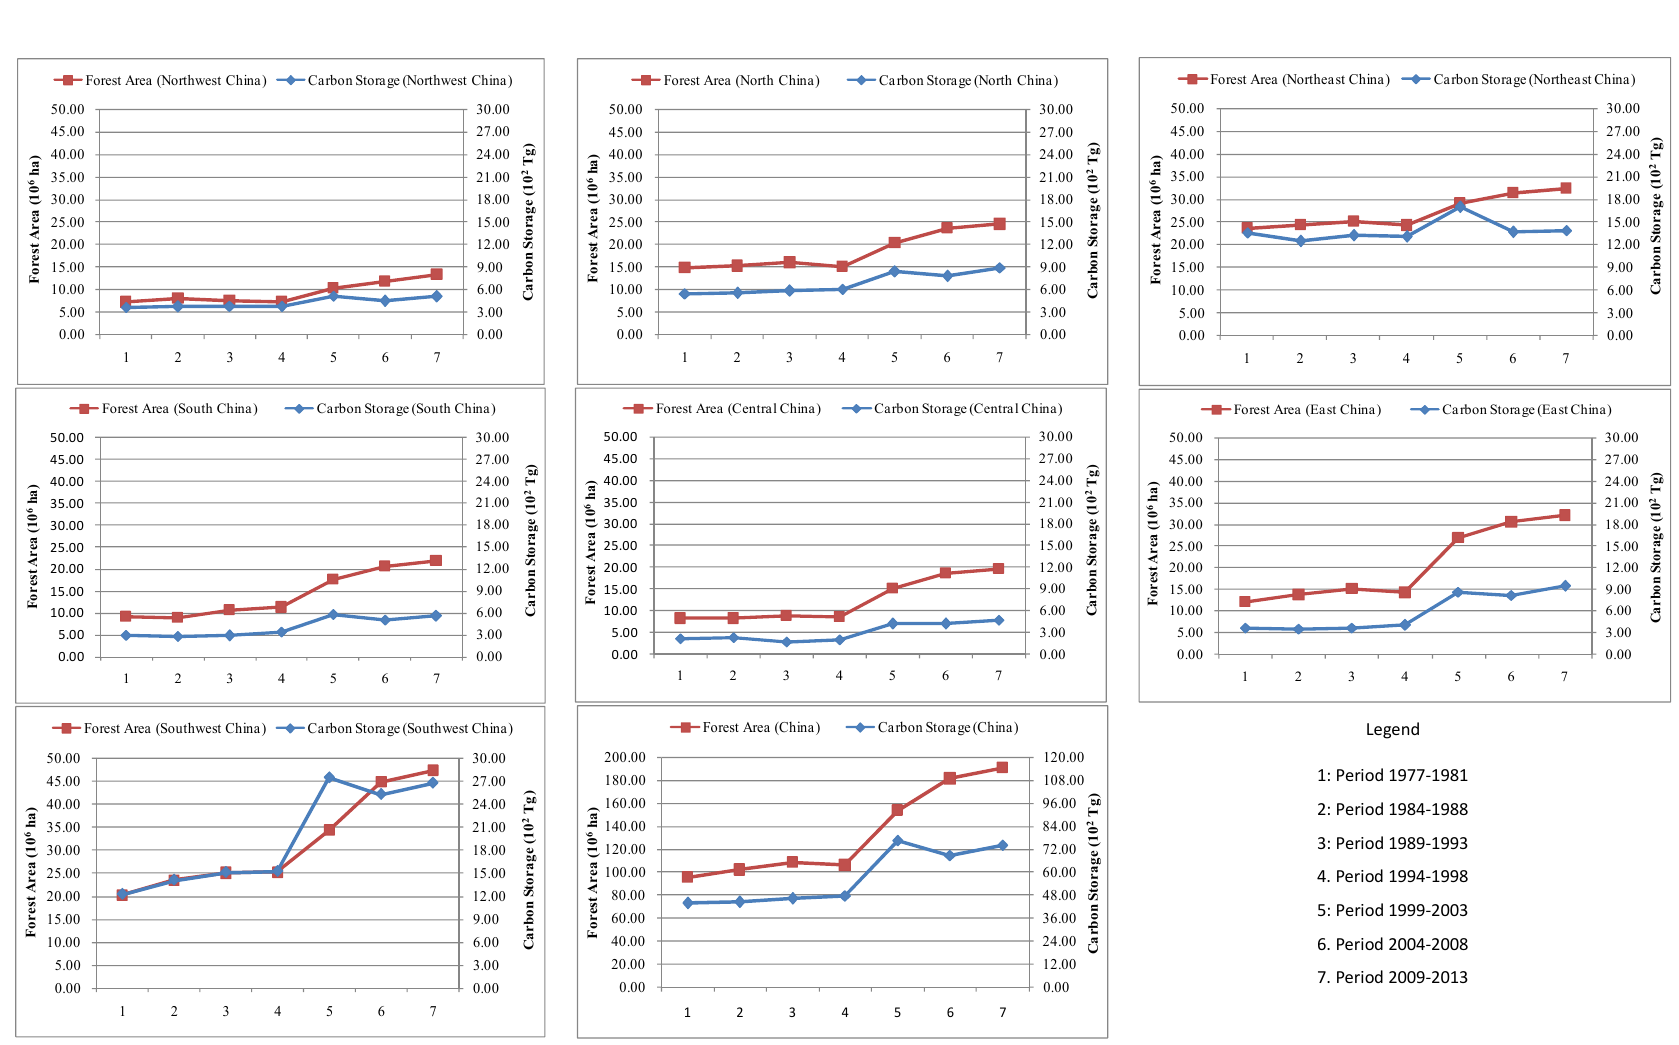
Figure 2. The relationship between FBCS and forest area in seven regions of China. Red and blue broken lines represented forest area and FBCS, respectively.